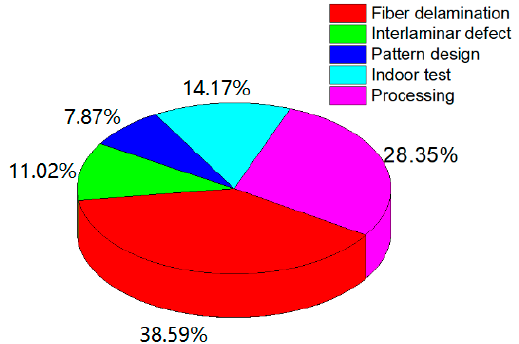
Figure 1. Rubber-fiber composite issues are directly related to approximately half of all tire problems. From arfc.org.